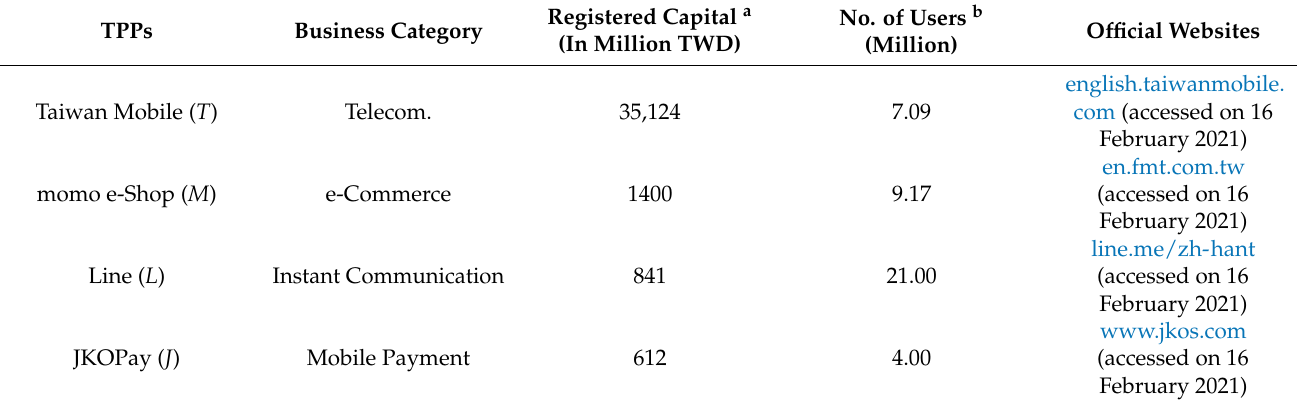
Table 6. Four third party providers’ (TPPs’)